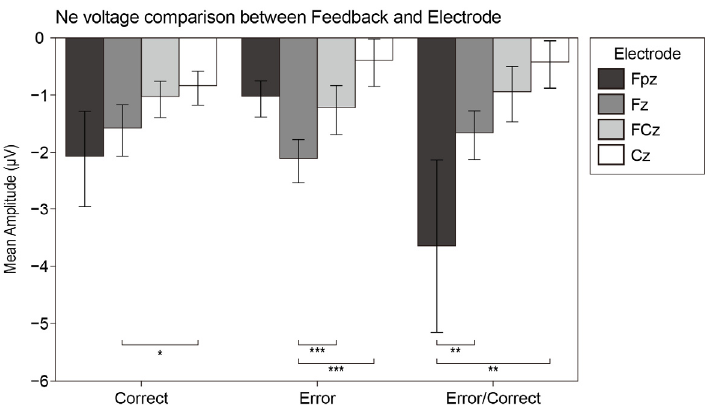
Figure 9. The bar plots of the interaction effect of Ne. Values plotted are means ± standard errors. Stars indicate significance levels: * = p < 0.05, ** = p < 0.01, *** = p < 0.001.